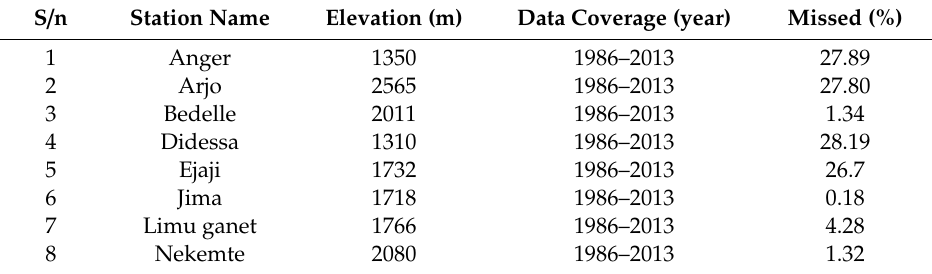
Table 1. The list of meteorological stations in the study